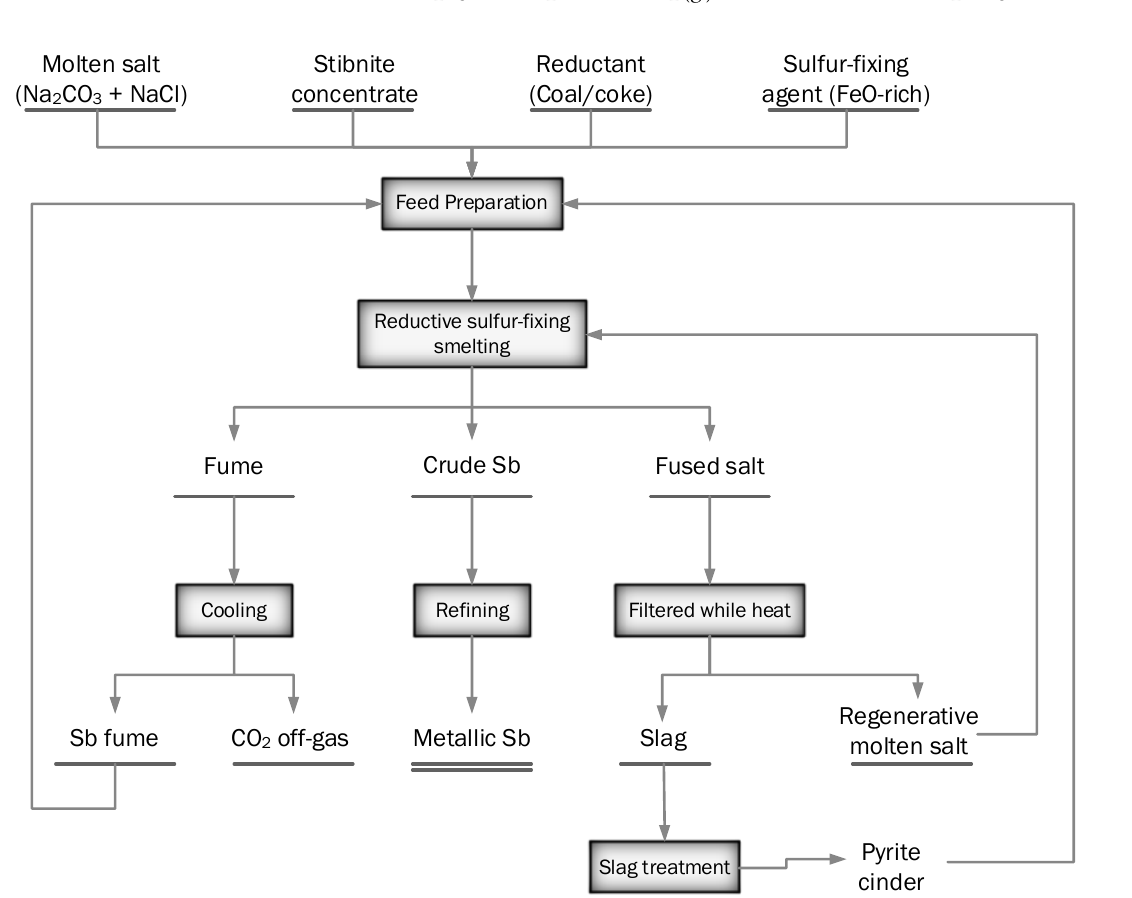
Figure 12. Flowsheet of reductive sulfur-fixing smelting of stibnite concentrate for one-step extraction of antimony at low temperature (adapted from [77]).